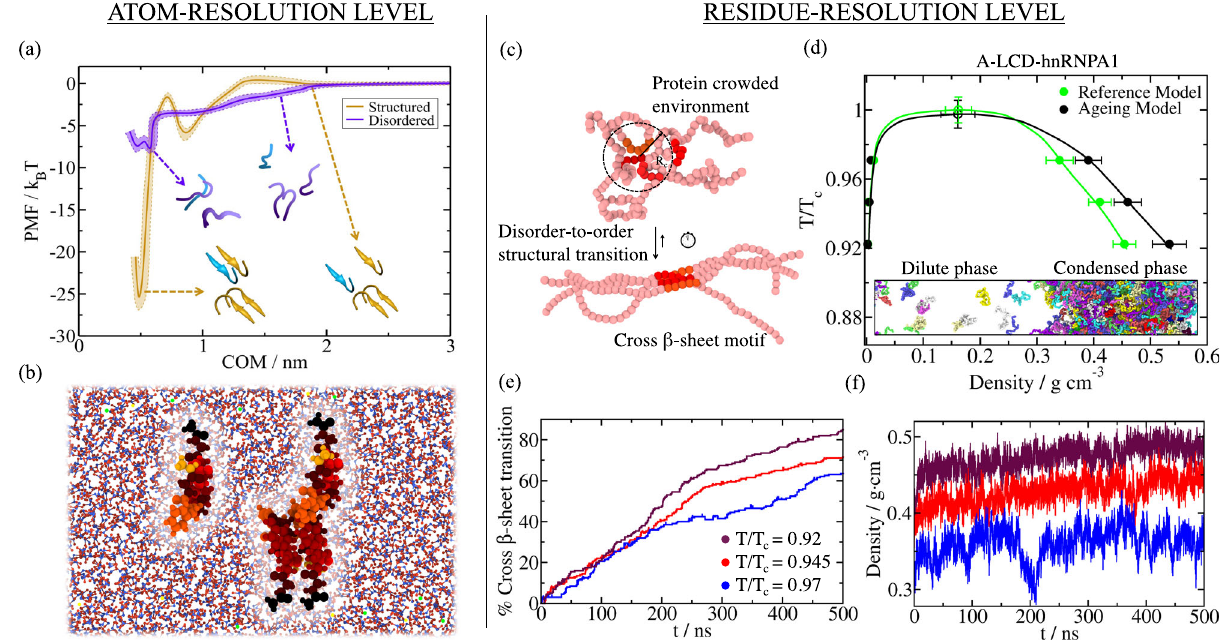
Fig. 1 | Structural transitions leading to inter-peptide β -sheet motifs dramati- cally increase protein binding and promotes droplet densi fi cation over time.